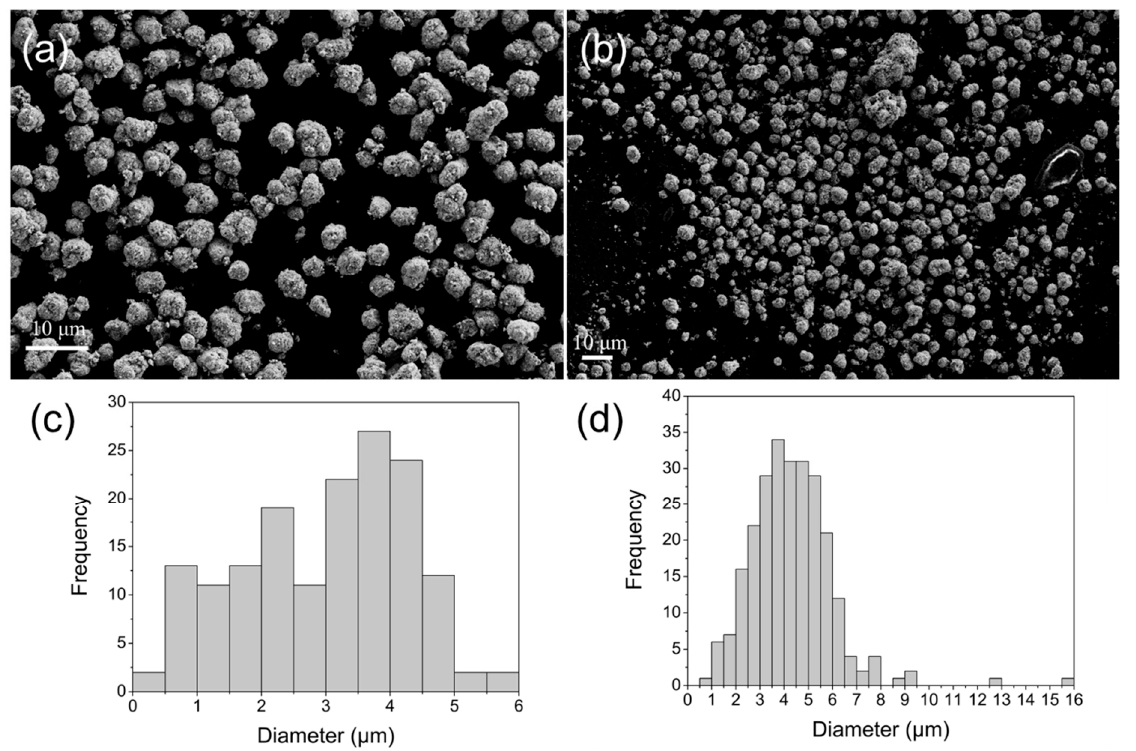
Figure 2. SEM of CeO 2 support and ReO x -Pd/CeO 2 catalyst. ( a ) CeO 2 1280 × magnification ( b ) ReO x -Pd/CeO 2 629 × magnification ( c ) CeO 2 particle size histogram ( d ) ReO x -Pd/CeO 2 particle size histogram.